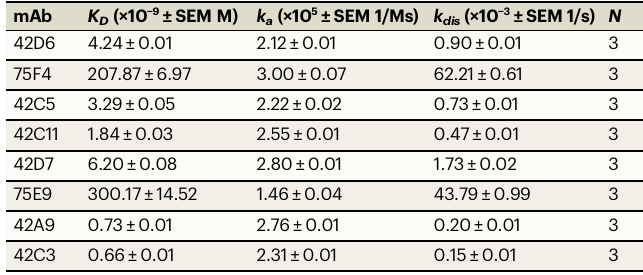
Table 1 | Kinetic rate constants of binding for Fab fragments of eight human mAbs to p19, as determined by BLI